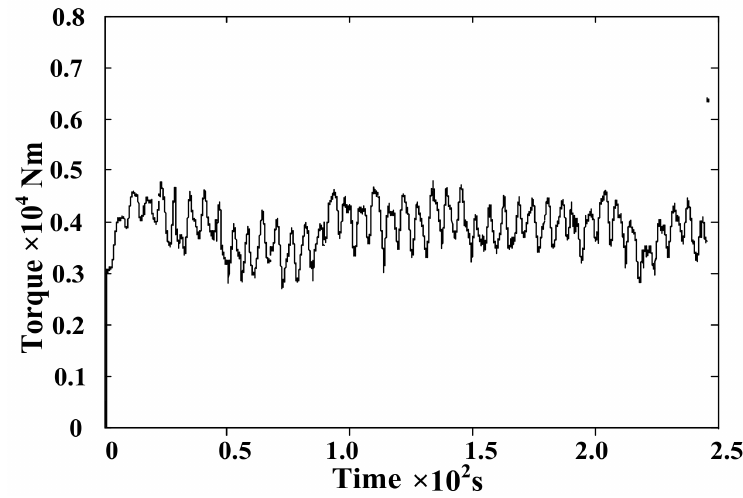
Figure 15. Torque without load.